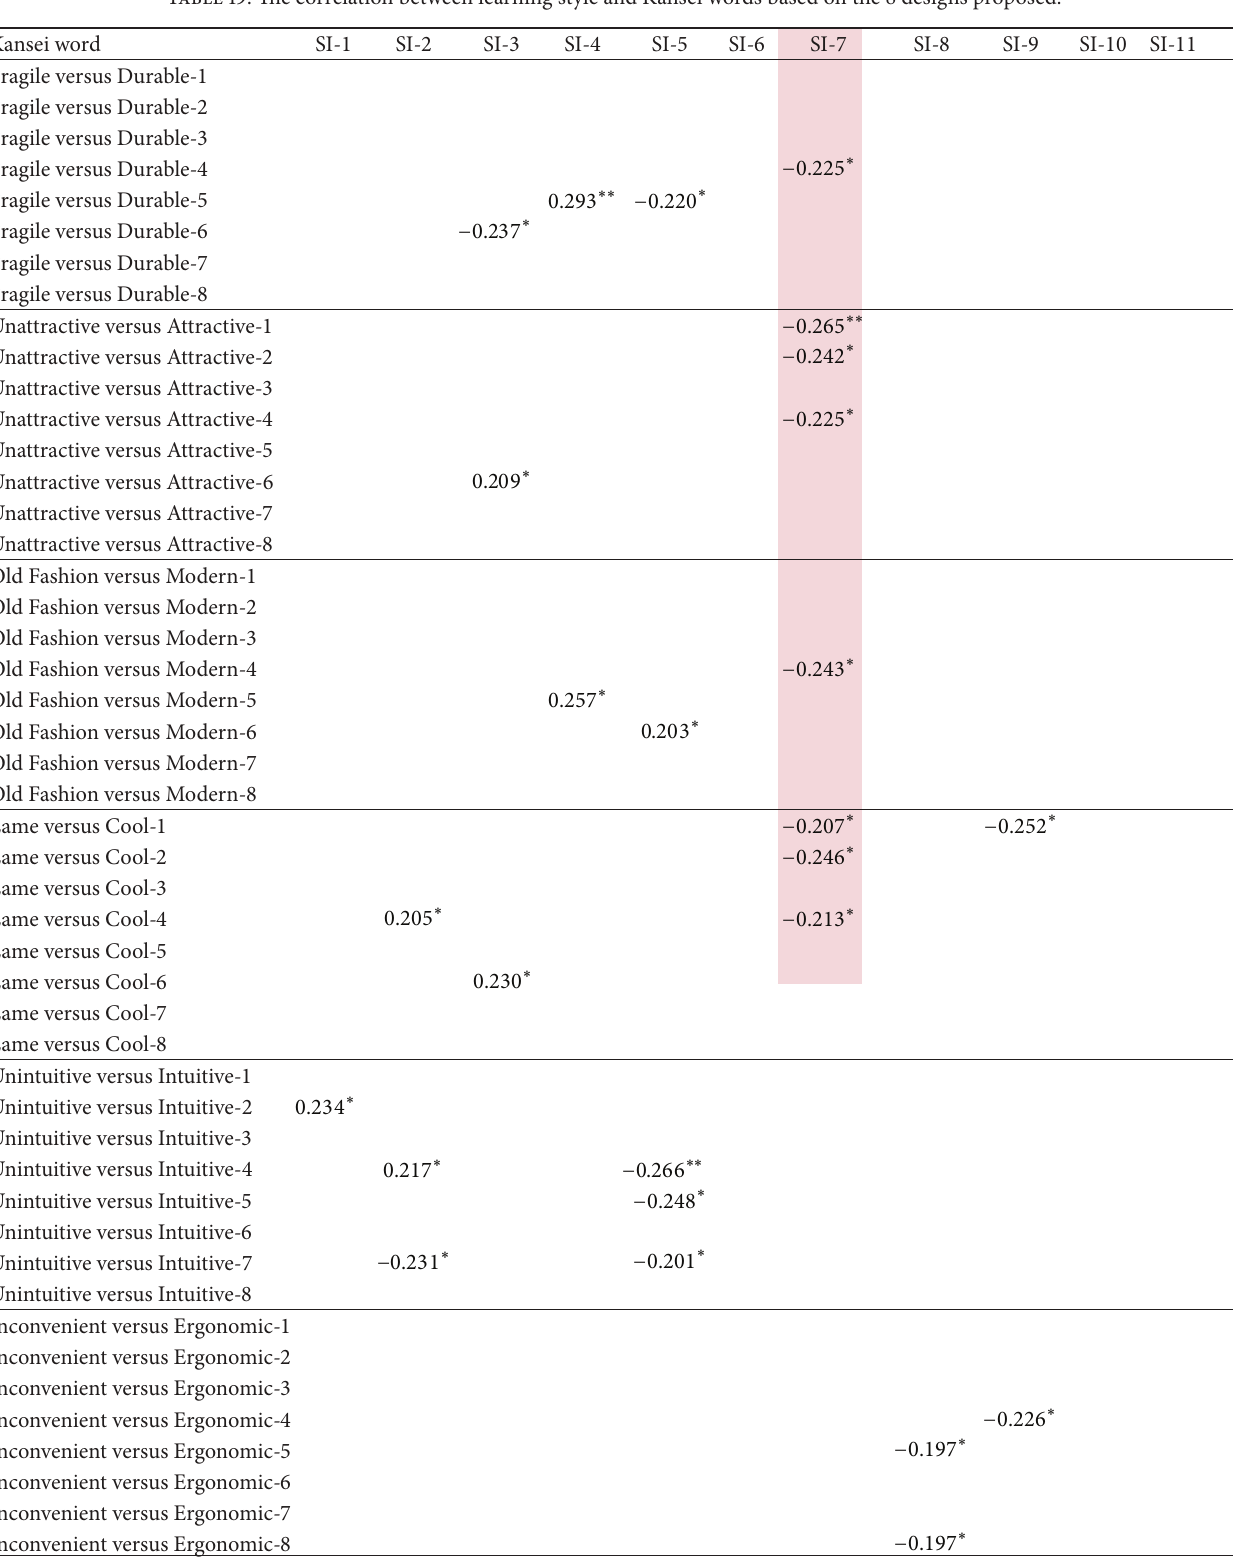
Table 19: The correlation between learning style and Kansei words based on the 8 designs proposed. Kansei